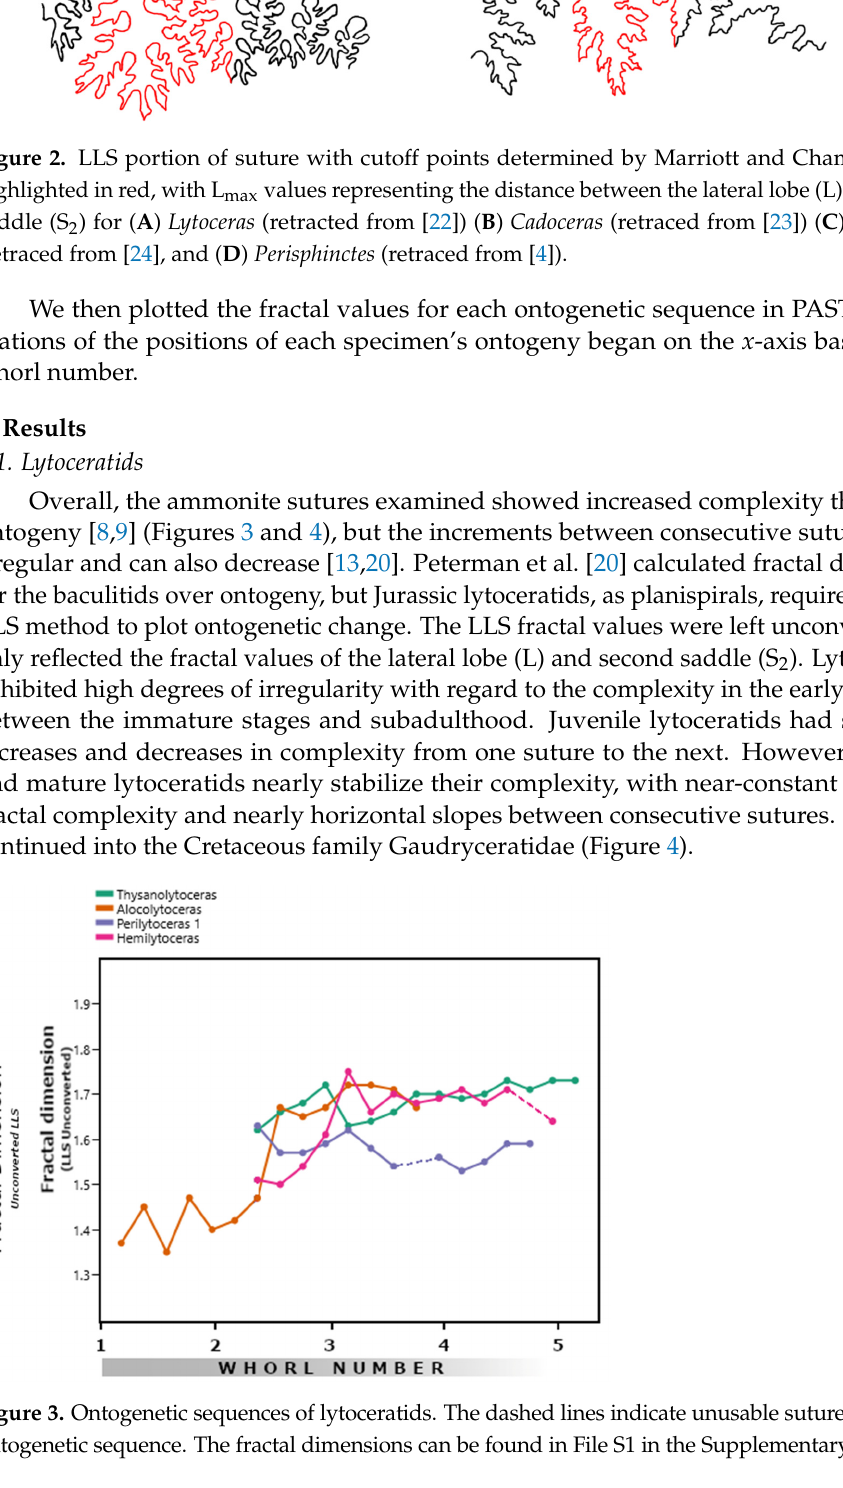
Figure 4. Decrease in variance in suture complexity over ontogeny for Lytoceratoidea, including Jurassic lytoceratids and Cretaceous gaudryceratids. 3.2. Hildoceratids Some hildoceratids, including members of Hildoceras and Harpoceras , exhibited tight whorl overlap such that the LLS data were not available from the photographed speci- mens. The LLS method is effective for these ammonites in the adult stage and in stein- kerns, but whorl overlap limits its ability to procure multi-whorled ontogenetic se- quences. For this reason, new conversion values needed to be devised that encompassed the next available saddle–lobe pair. The second saddle (S 2 ) and third umbilical lobe (U 3 ) were chosen for this purpose, which we designated as a “secondary conversion value”, or V ′ . The secondary conversion value was calculated in exactly the same way as the primary